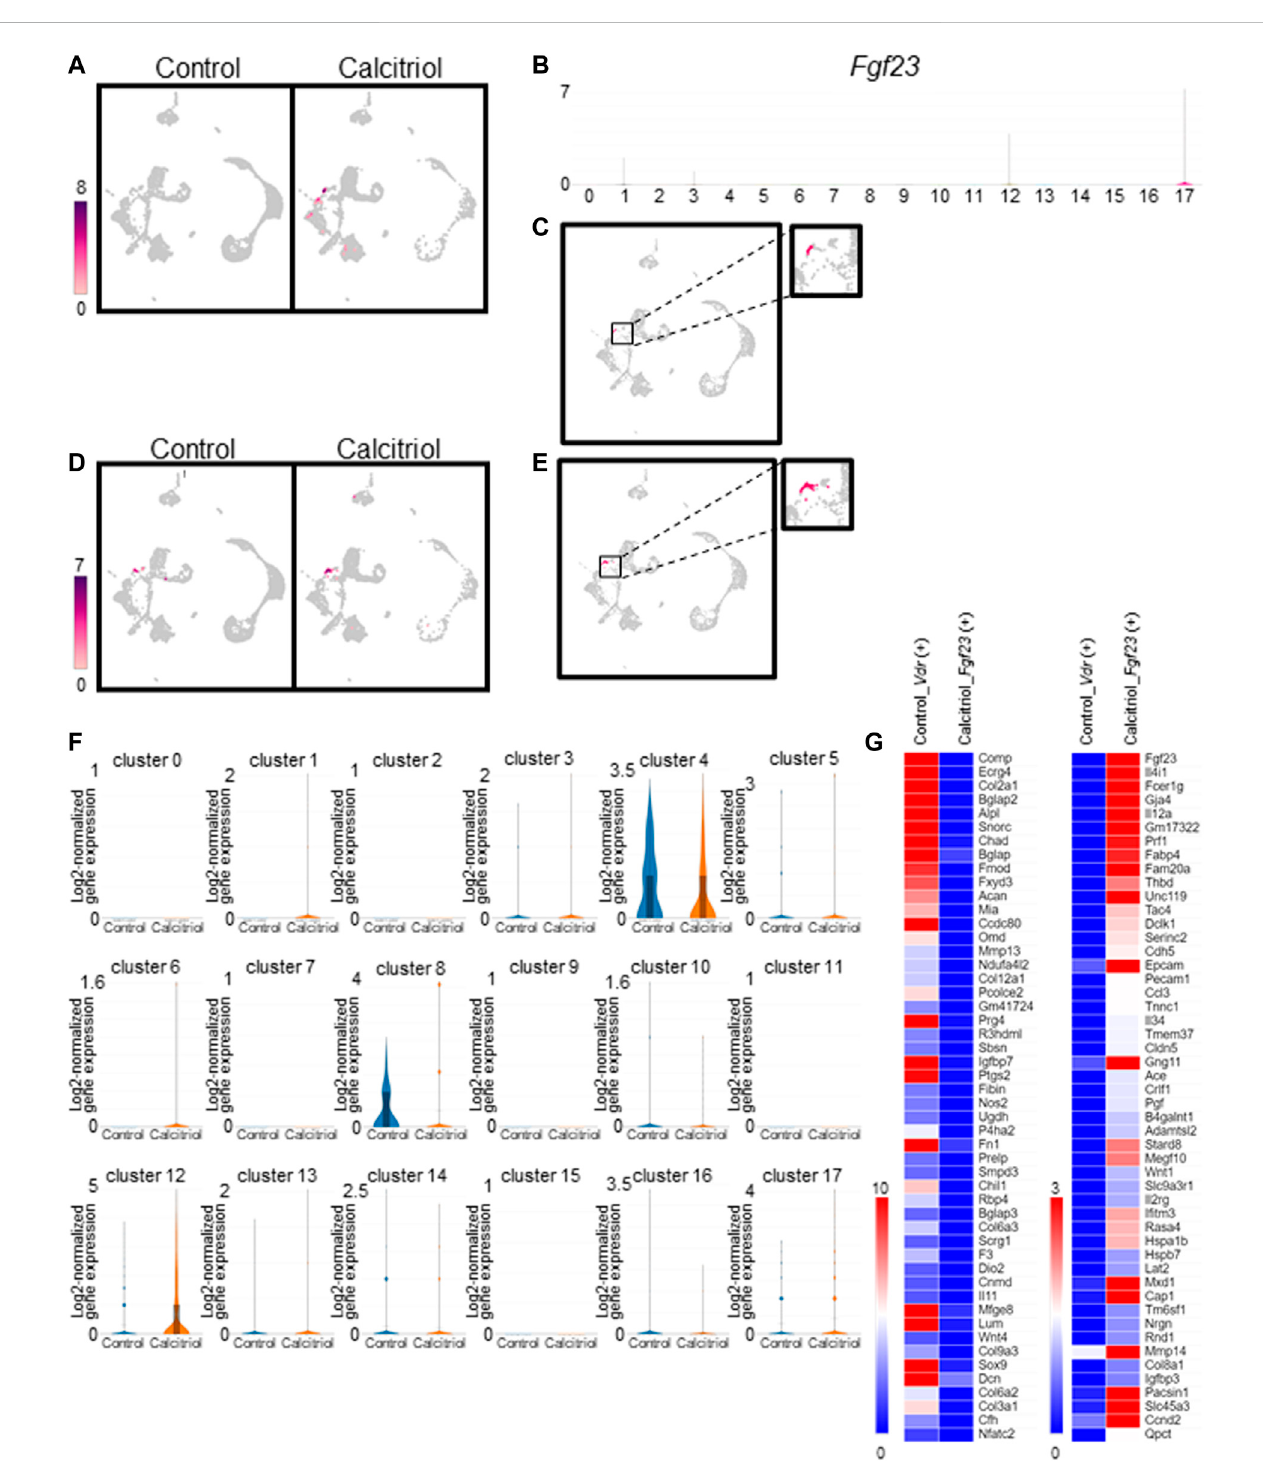
FIGURE 4 Identi fi cation and characterization of Fgf23 -expressing cells in fresh cells isolated from femurs of calcitriol-injected mice. (A) Uniform Manifold Approximation and Projection (UMAP) plot showing Fgf23 gene expression in all cells from calcitriol-injected mice or control mice. Color scale bar shows log2-normalized gene expression values. (B) Violin plots indicate cluster-speci fi c expression of Fgf23 gene. (C) UMAP plot showing Fgf23 gene expression in osteocytes(cluster #17)ofcalcitriol-injected mice. (D) UMAPplotshowing Sost geneexpressioninallcellsfromcalcitriol-injectedmiceorcontrolmice. Color scale bar shows log2-normalized gene expression values. (E) UMAP plot showing Sost gene expression in osteocytes (cluster #17) of calcitriol-injected mice. (F) Violin plots indicate Vdr gene expression in the untreated and calcitriol-injected mice in each cluster. (G) The gene expression was compared between Fgf23 -expressing osteocytes in calcitriol-injected group and Vdr -expressing osteocytes in control group. Heat maps indicate gene expression pro fi les upregulated (right) or downregulated (left) in Fgf23 -expressing osteocytes in calcitriol-injected